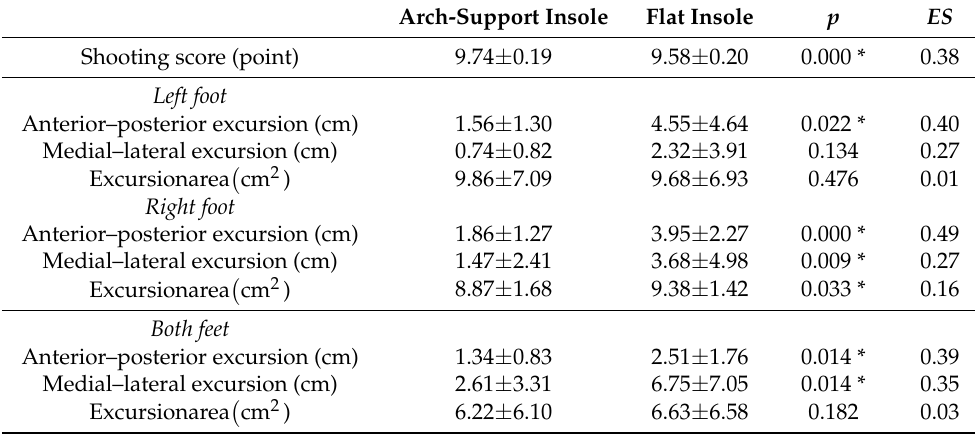
Table 1. Comparison of parameters between arch support and flat insole.